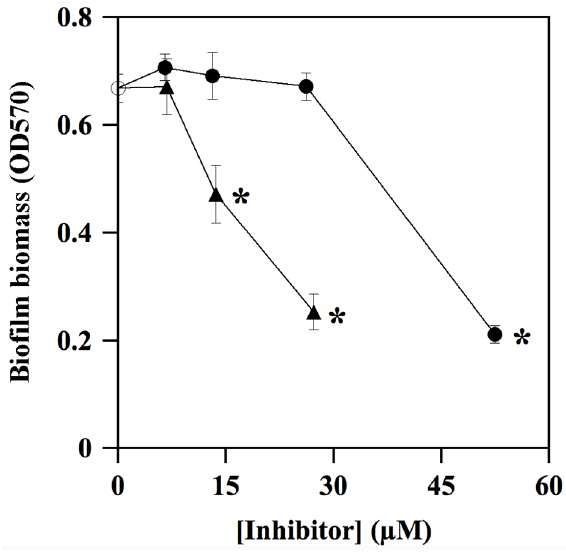
Figure 9. Effect of ALS-31 and ALS-31-9 on the antibiofilm activity of Streptococcus mutans cultures. The inhibition of total biofilm biomass formation of S. mutans was investigated and evaluated, as indicated in Materials and Methods, in the absence ( ) or in the presence of the indicated concentration of ALS-31 ( ) or ALS-31-9 ( ). ( ): p < 0.0001 compared to control.